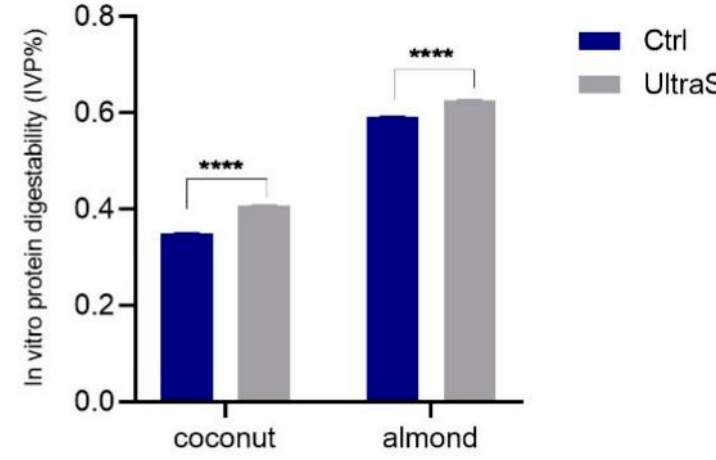
Figure 5. In vitro digestibility ( IVPD% ) of the same samples, (****) p <